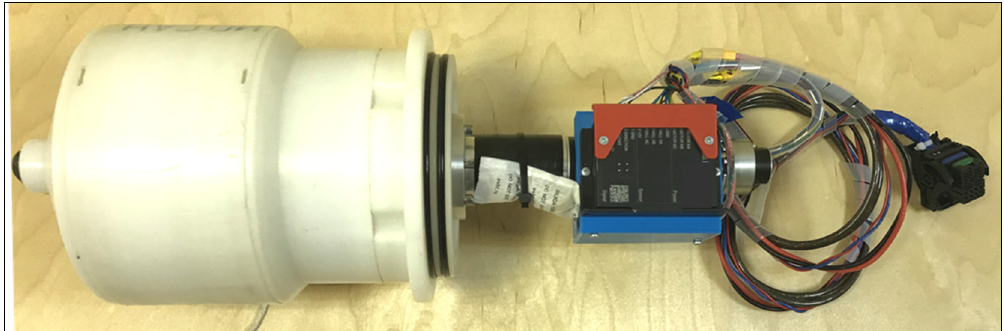
Figure 6. The winch mounted on the DC geared motor with a motor speed controller.